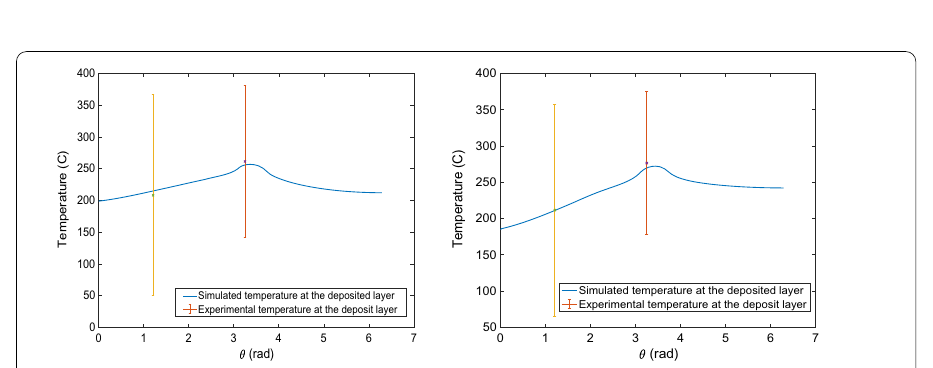
Fig. 6 Comparison of the simulated temperature in the middle of the top layer, with experimental measurements, for the 3rd and 5th layer deposition. Temperatures in ◦ C